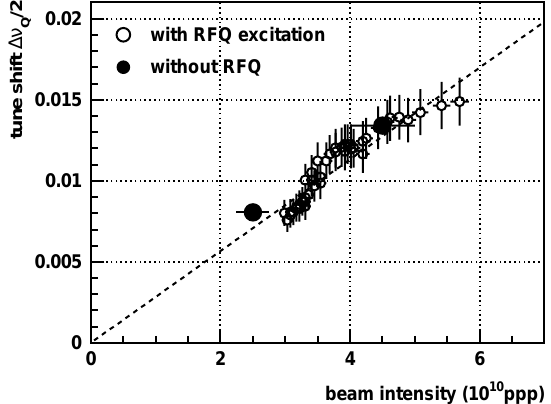
FIG. 3. Space-charge-induced tune shift of vertical quadrupole mode coherent